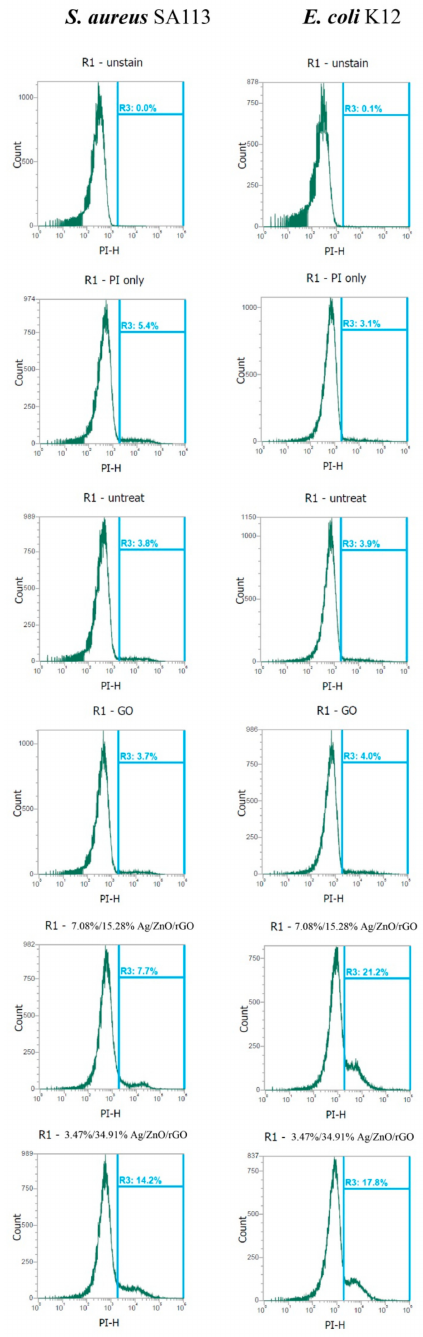
Figure 8. Analysis of propidium iodide (PI) staining intensity in E. coli K12 and S. aureus SA113 strains. These two strains were grown in MHB supplemented with 100 ppm of 3.47 / 34.91% and 7.08 / 15.28% Ag / ZnO / rGO composites for 3 h, and the cells were then treated with PI (green). The X-axis represents the PI intensity in arbitrary units (a.u.) and the Y-axis represents the cell counts as measured by flow cytometry. PBS-only and unstained cells were used as the controls. PI fluorescence is presented in a false blue color. PBS bu ff er only: addition of only PBS bu ff er (no cells or fluorescent dyes); unstained: untreated bacterial cells that did not stain with fluorescent dyes; PI only: untreated bacterial cells stained with PI dye only without Redox dye; Redox only: bacterial cells stained with Redox dye but not PI dye; Ag / ZnO / rGO: bacterial cells stained with both PI and Redox dyes at 100 ppm Ag / ZnO / rGO. All parameters were collected as logarithmic signals. Data are representative of two separate